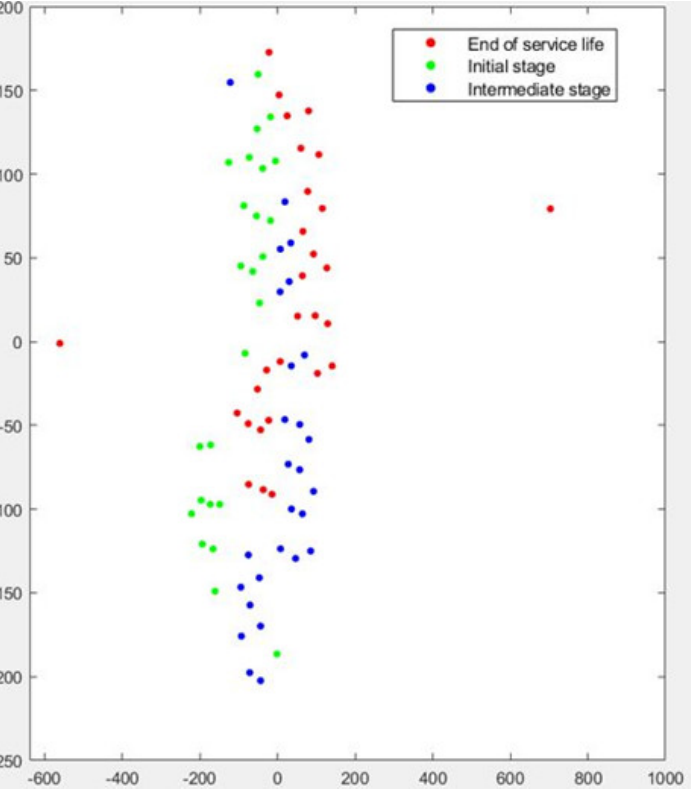
Figure 7. Graphical results of t-SNE dimensionality reduction for Test No. 1.